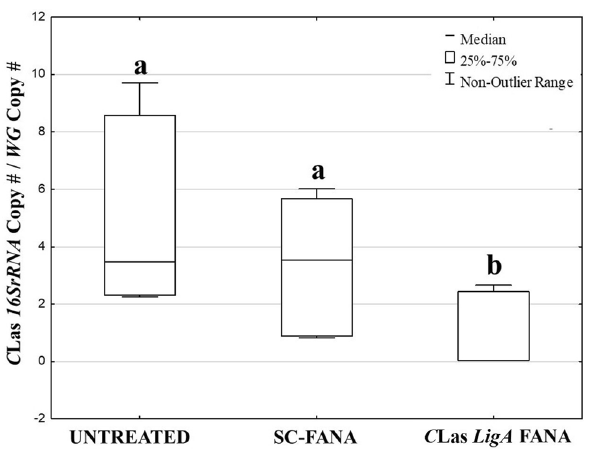
Figure 5. Effect of FANA ASO on mRNA levels of C Las LygA in D. citri adults. The markers represent the expression of the target gene in the experimental condition compared to its expression in the untreated condition. Values lower than 1 indicates gene suppression. Results are means of triplicate experiments ± SE. ** P ≤ 0.001 (TIBCO Statistica, v. 13.3.0: https ://www.tibco .com/produ cts/data-scien